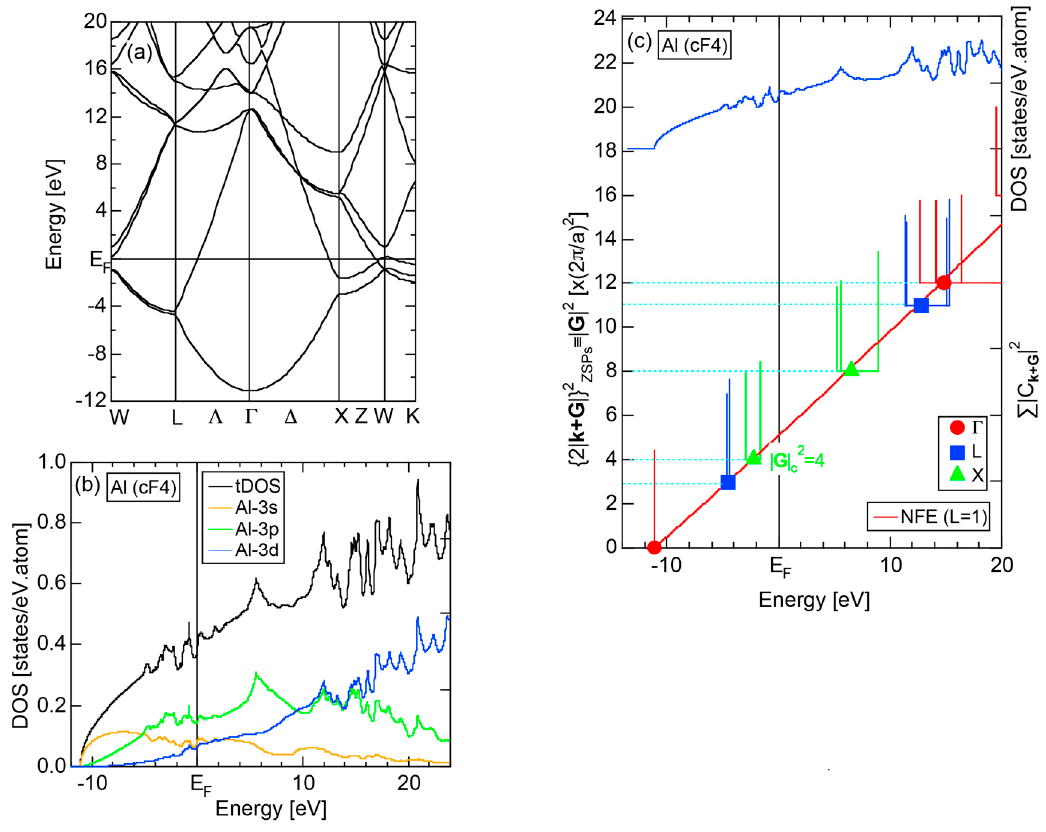
Figure 10. ( a ) Dispersion relations; ( b ) total- and partial-DOSs and ( c ) FLAPW-Fourier spectra at symmetry points Γ , L and X of the fcc Brillouin zone for Al (cF4) [11]. Its total-DOS is incorporated in ( c